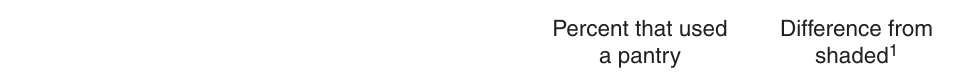
Percent that used Difference from a pantry shaded 1 10.4 -10.3*** 15.2